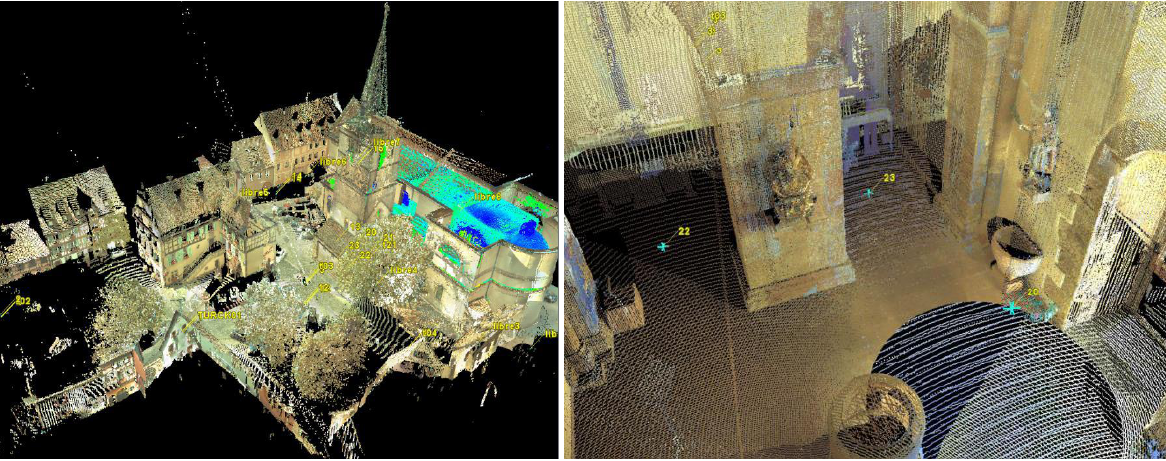
Fig. 3: Global consolidated point clouds Fig. 4: Extract of chapel point cloud with